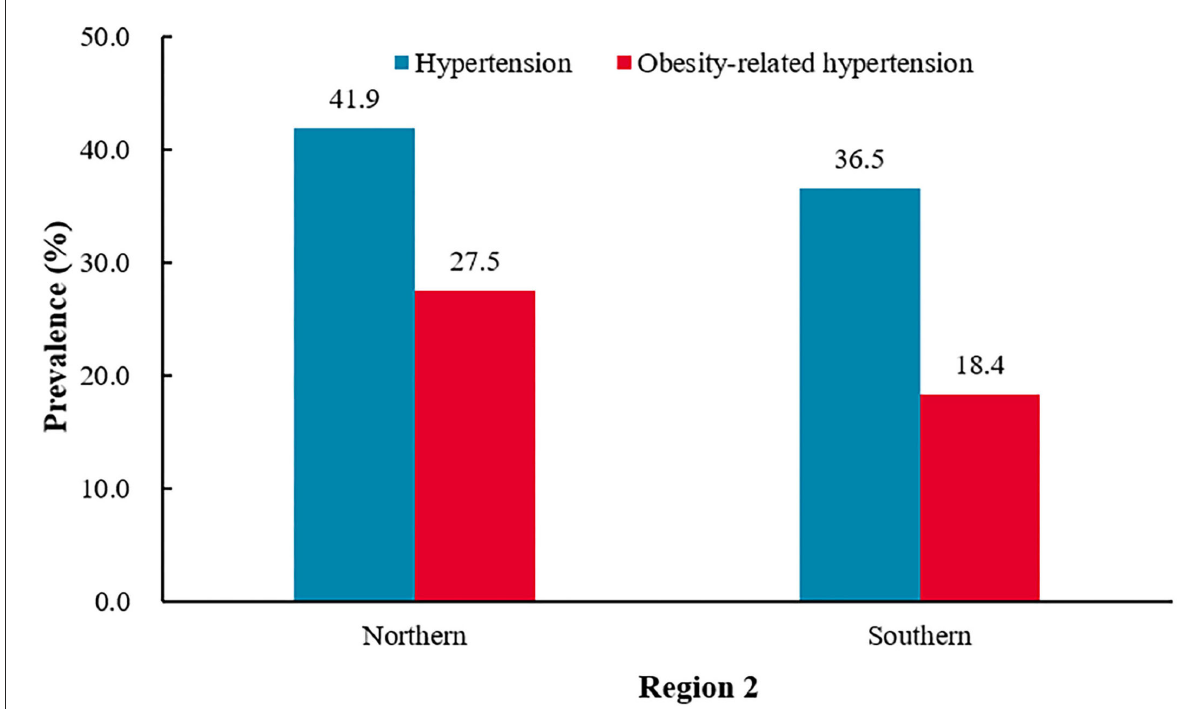
FIGURE5 The prevalence of hypertension and obesity-related hypertension among Northern and Southern provinces. † P < 0.0001 for the difference in the prevalence of hypertension between Northern and Southern provinces. ‡ P < 0.0001 for the difference in the prevalence of hypertension obesity-related hypertension between Northern and Southern provinces.